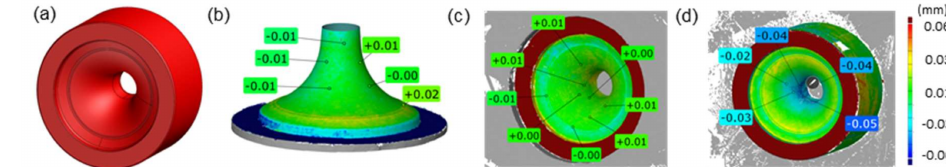
Figure 7. View of: ( a ) CAD model of nominal geometry, ( b ) coloured map of deviations of the die replica from the CAD model, ( c ) coloured map of deviations of the reverse scan of the replica from the CAD model (small errors pointing to high accuracy), ( d ) coloured map of deviations of the die’s 3D scan from the CAD model (for the angle value of up to 55 ◦ —default